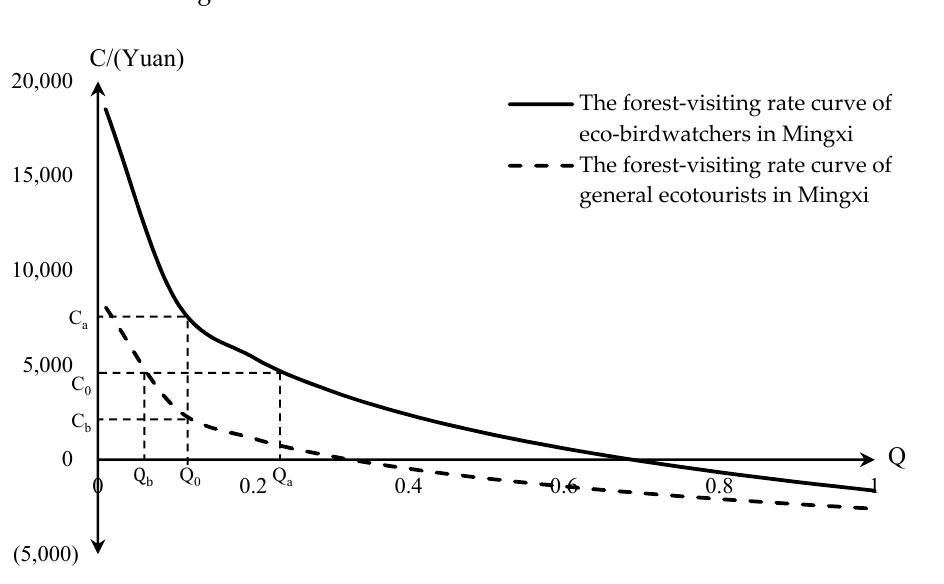
Figure 3. The demand curve of eco – birdwatchers and general ecotourists’ willingness to travel.